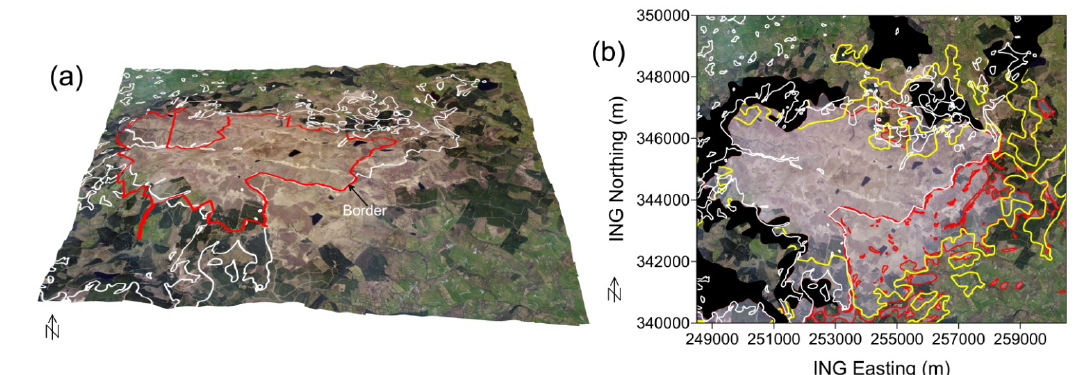
Figure 8. The 12 × 10 km study area across the Slieve Beagh blanket bog in both Northern Ireland and the Republic of Ireland. ( a ) Perspective view, looking north, with ariel image draped on DTM. Ramsar site shown by red contour (extends to border). Mapped peat locations (DiGMAPGB50) shown by white contours. ( b ) Orthographic view of ariel image with mapped peat locations (DiGMAPGB50, UK) shown by white contours. Red contours denote peat (soil) mapping in the Republic of Ireland (RoI). Yellow contours denote CORINE land-use mapping of peat bogs (UK and R0I). ING refers to Irish National Grid